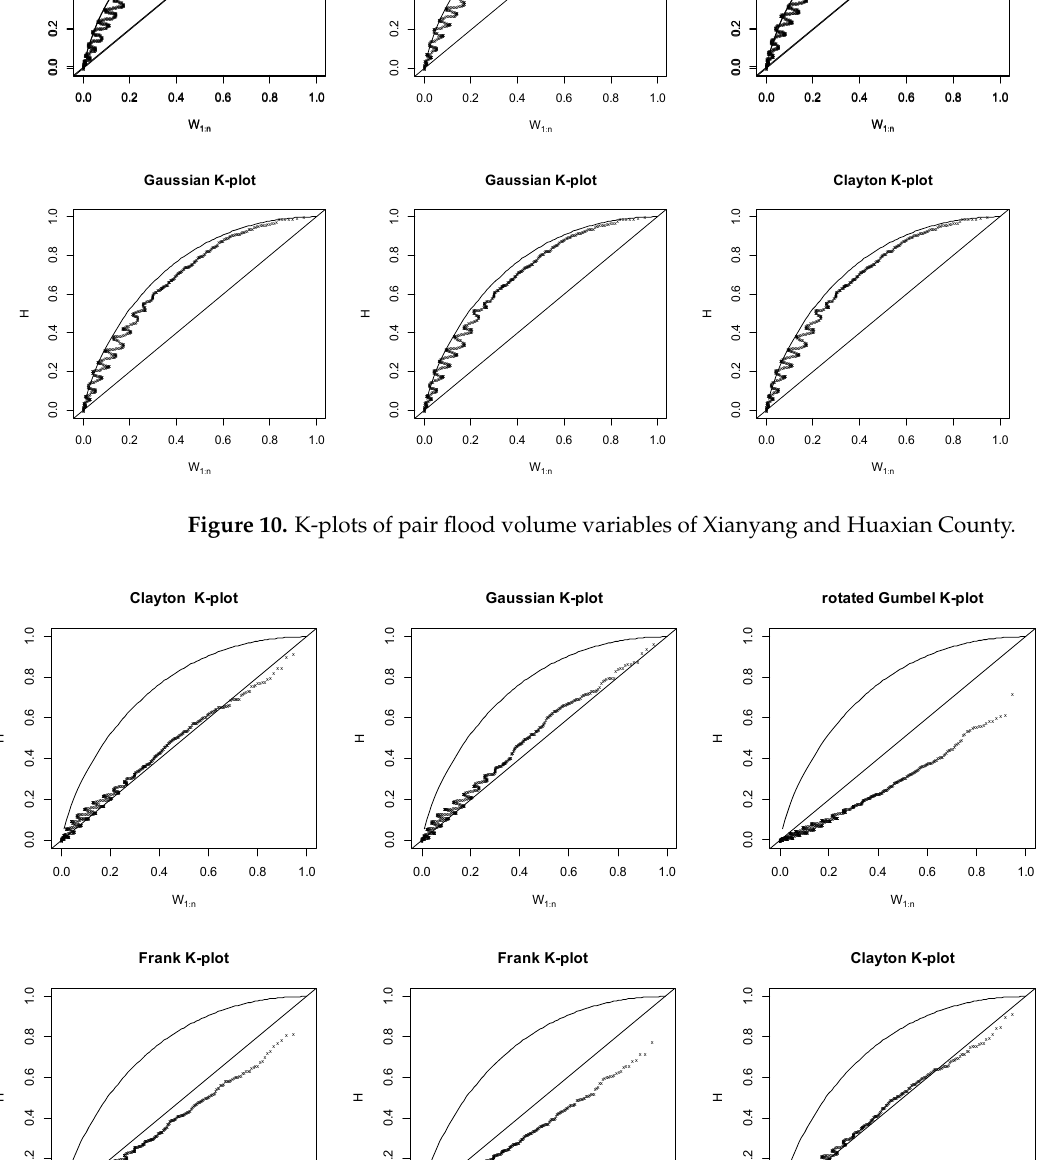
Figure 11. K-plots of pair flood volume variables of Zhangjiashan and Huaxian County.